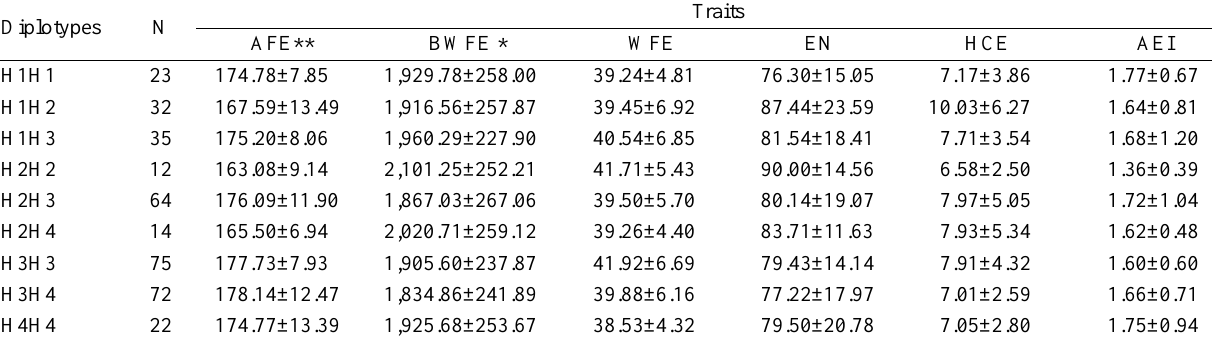
Table 4. Associations of diplotypes of CRBP3 gene with laying performance traits